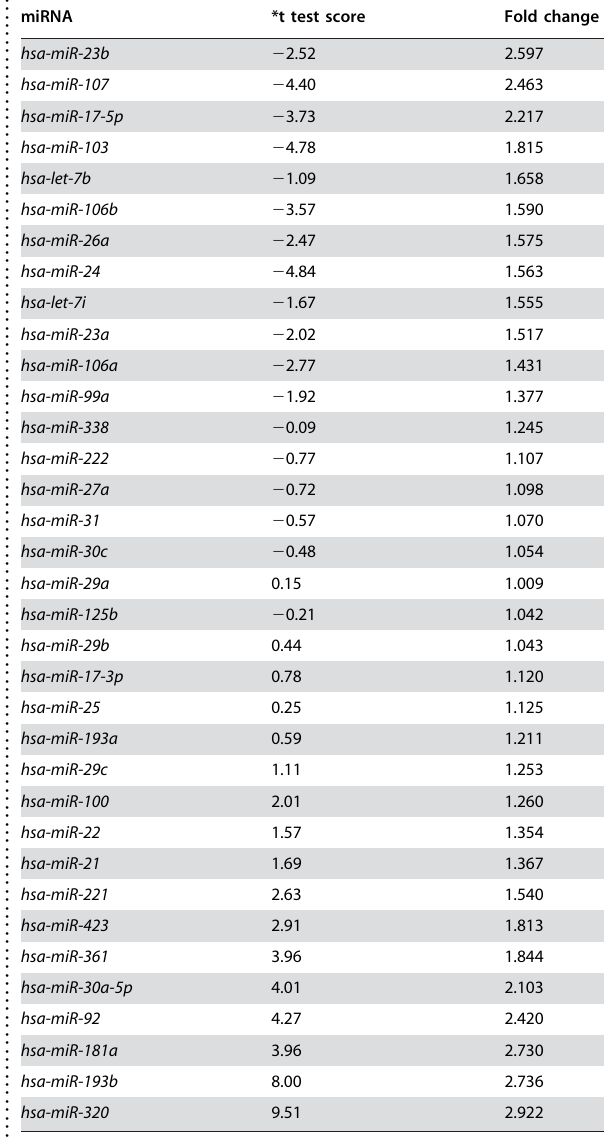
Table 3. microRNAs non-differentially expressed in CNE with miRNA *t test